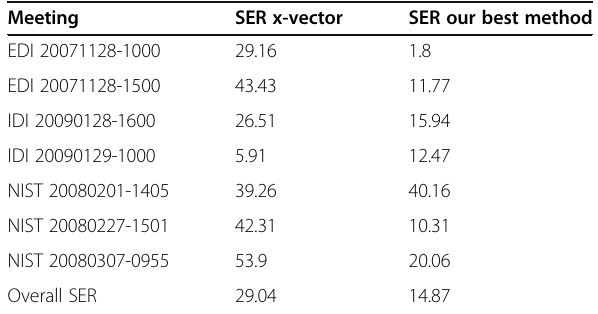
Table 16 Detailed comparison for the RT09 of our best system with an x-vector system